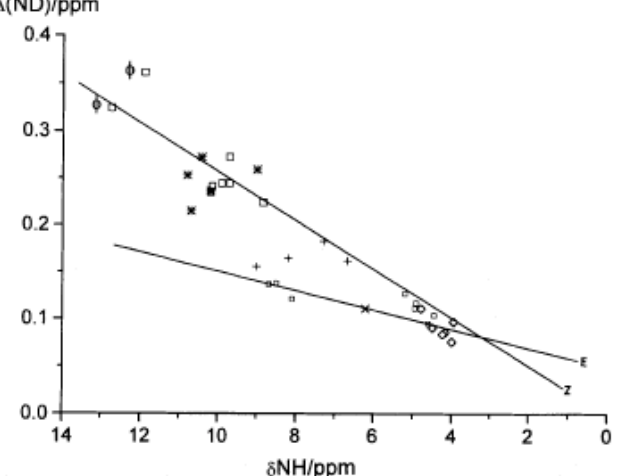
Figure 19. Plot of two-bond deuterium isotope effects on 13 C chemical shifts vs. NH chemical shifts for enamines. Open squares ( Z )-enaminones, closed squares ( E )-enaminones, + enamino esters, * ( Z )-nitroenamines, crosses ( Z )-sulphinylenamines and diamonds ( E )-sulphinylenamines, ϕ indicates N ‐ phenyl groups. Taken from [32] with permission from Wiley.